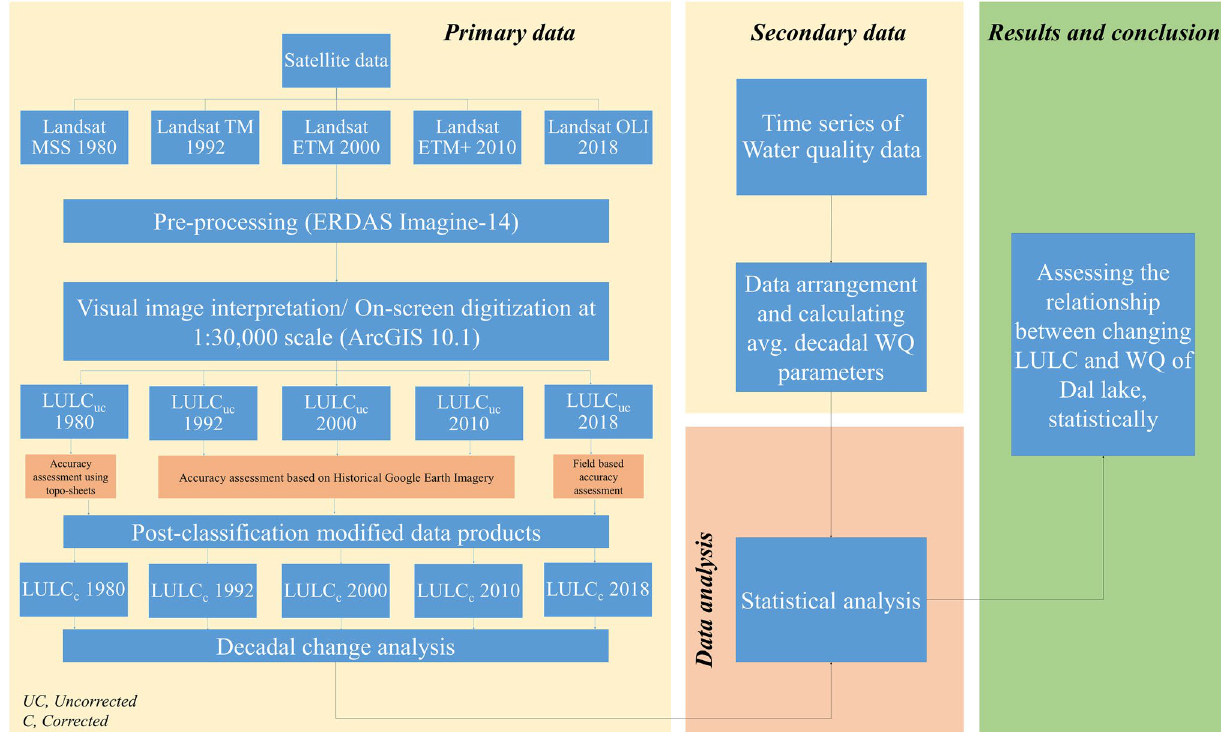
Fig. 2 Flowchart of the overall methodology